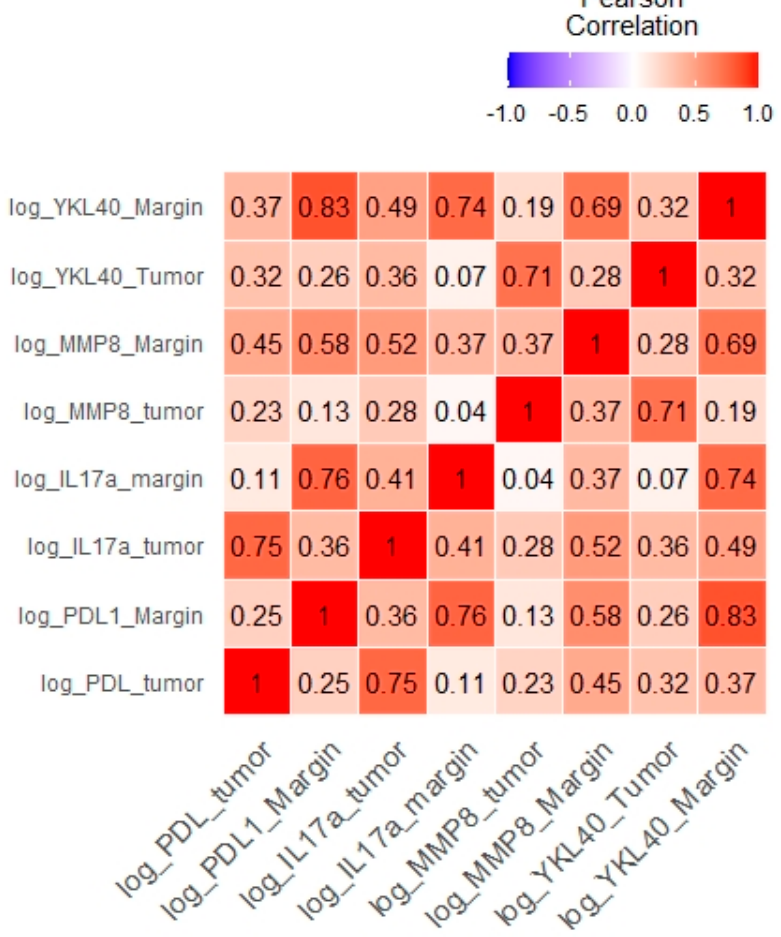
Figure 7. Correlations between the levels of the examined molecules presented as a heat map.